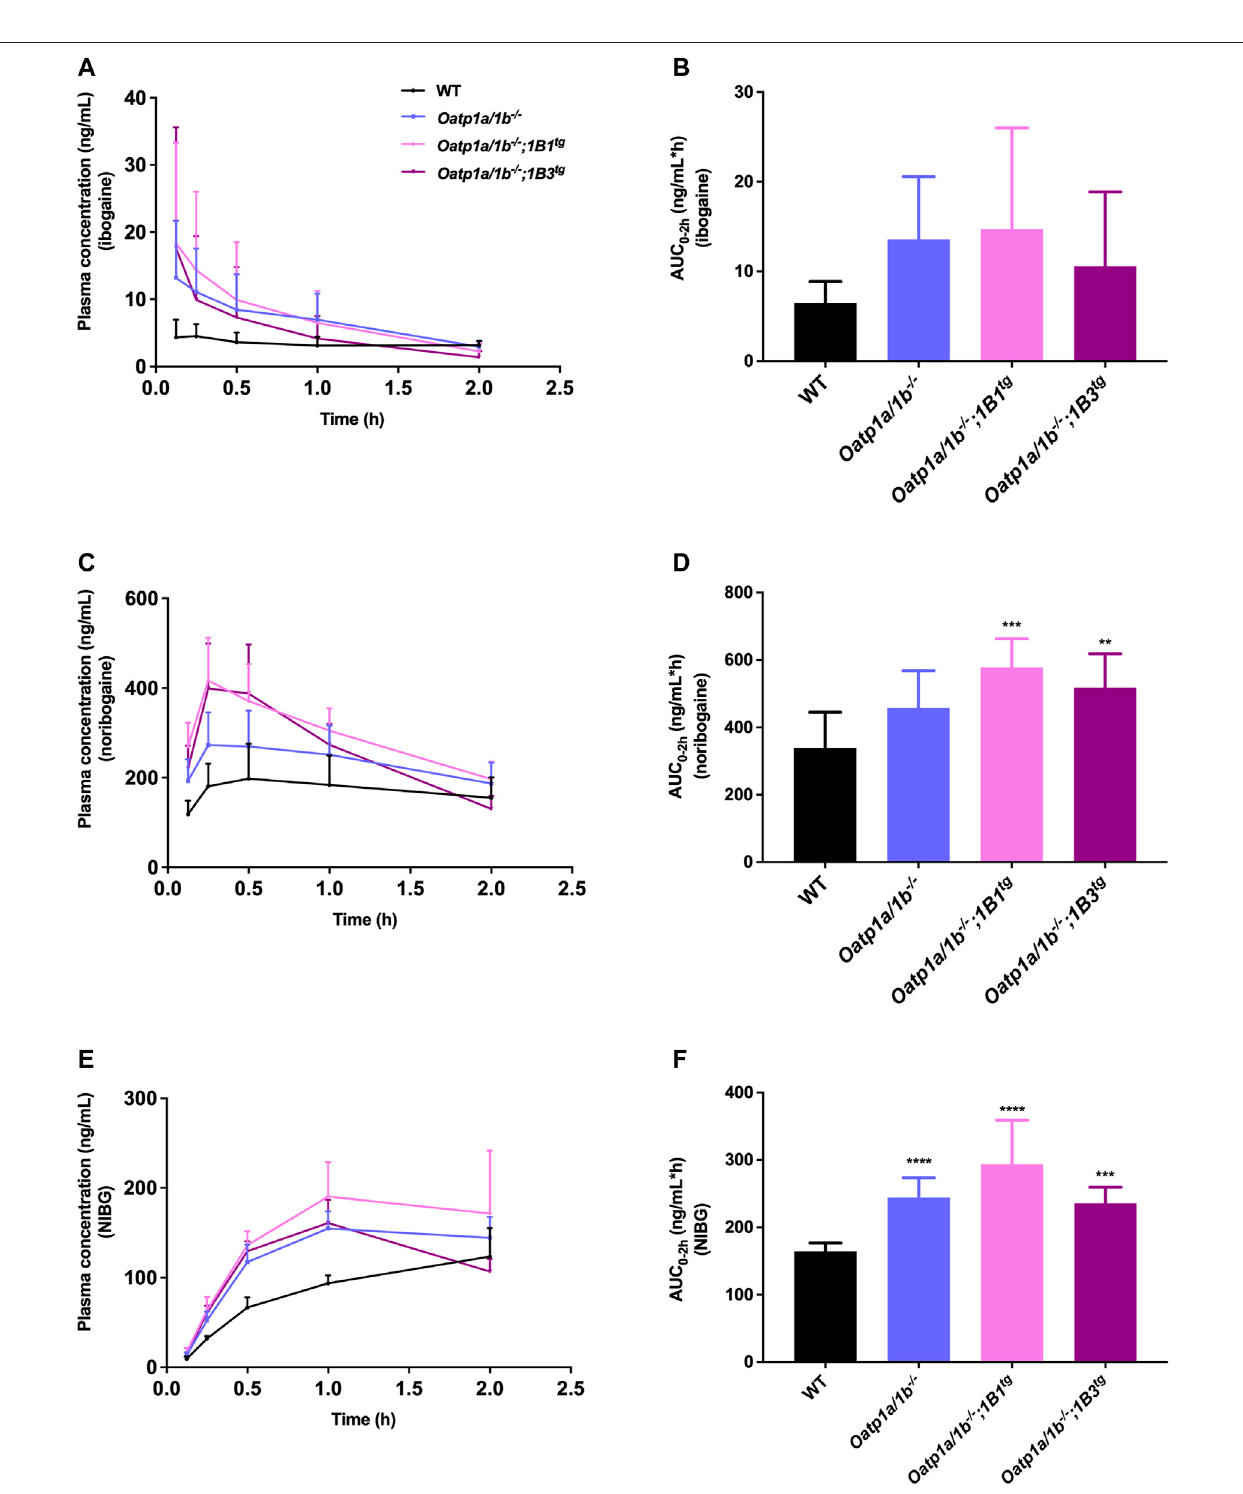
FIGURE 4 | Plasma concentration-time curves and plasma AUCs of ibogaine (A,B) , noribogaine (C,D) , and noribogaine glucuronide (NIBG) (E,F) , respectively, in female wild-type (WT), Oatp1a/1b − / − , Oatp1a/1b − / − ;1B1 tg , and Oatp1a/1b − / − ;1B3 tg mice, over 2 h after oral administration of 10 mg/kg ibogaine ( n = 7). Data are presented as mean ± SD.**, p < 0.01; ***, p < 0.001; ****, p < 0.0001 compared to wild-type mice.